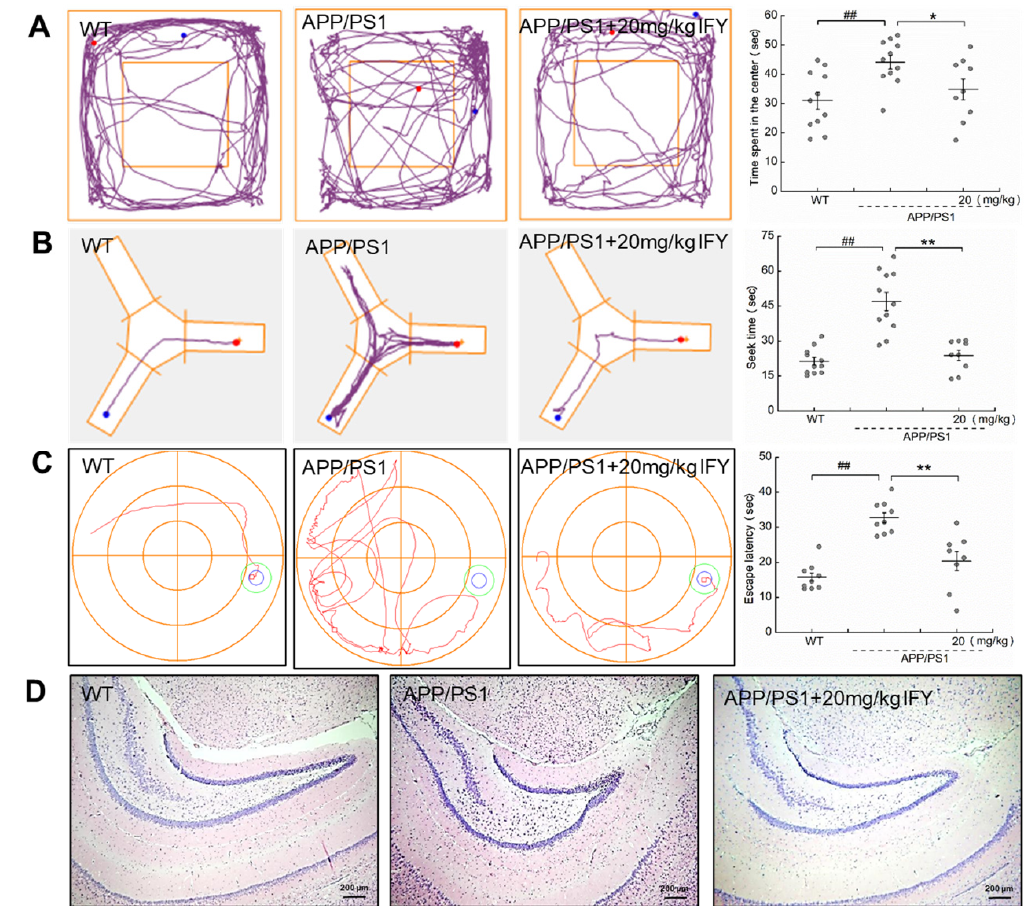
Figure 2. IFY ameliorated the cognitive deficiency in APP/PS1 mice. ( A ) IFY shortened the time spent in the center of the open field test. ( B ) IFY curtailed the time spent in seeking food in the Y-maze test. ( C ) IFY reduced the time spent in locating the platform of the Morris water maze (MWM) test ( n = individual dots displayed for each group in all graphs). Data were shown as the mean ± SEM. ## p < 0.01 vs. wild type (WT) mice, * p < 0.05, ** p < 0.01 vs. APP/PS1 mice. ( D ) IFY showed no significant effect on mice brain tissues detected by hematoxylin–eosin (H&E) staining. (magnification × 4, scale bar: 200 μ m ( n = 3)).